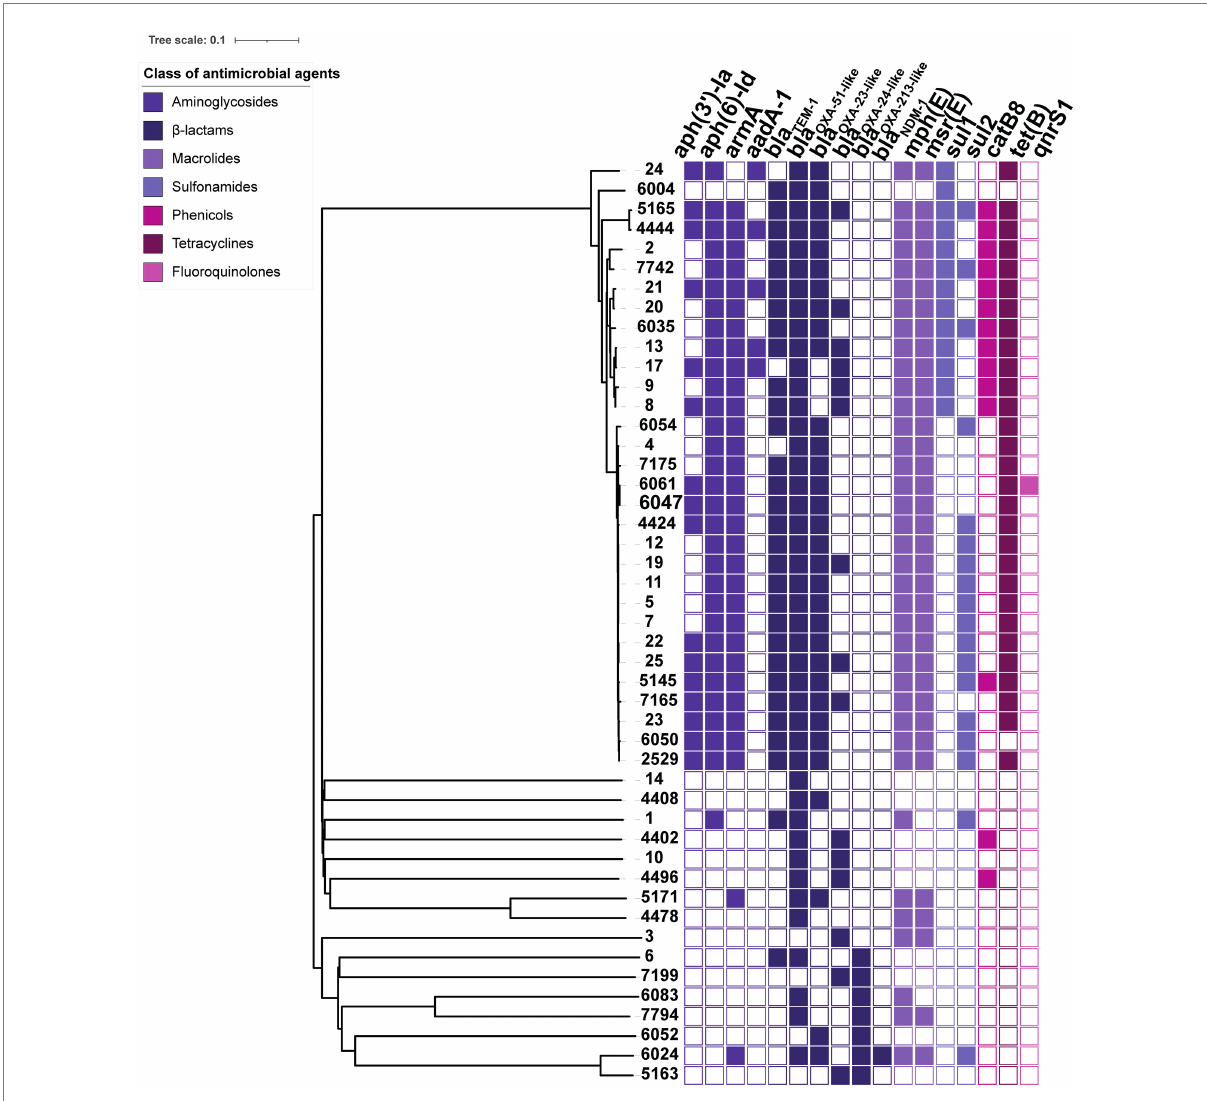
FIGURE 2 Phylogenetic relationship based on the core genome among 47 BSI A. baumannii isolates and the heatmap of resistance determinants. In the heatmap, colour-filled rectangles indicate the positive resistance determinants, and colour-empty rectangles indicate the negative resistance determinants. Different colours represent the classes of antimicrobial agents to which the isolate confers